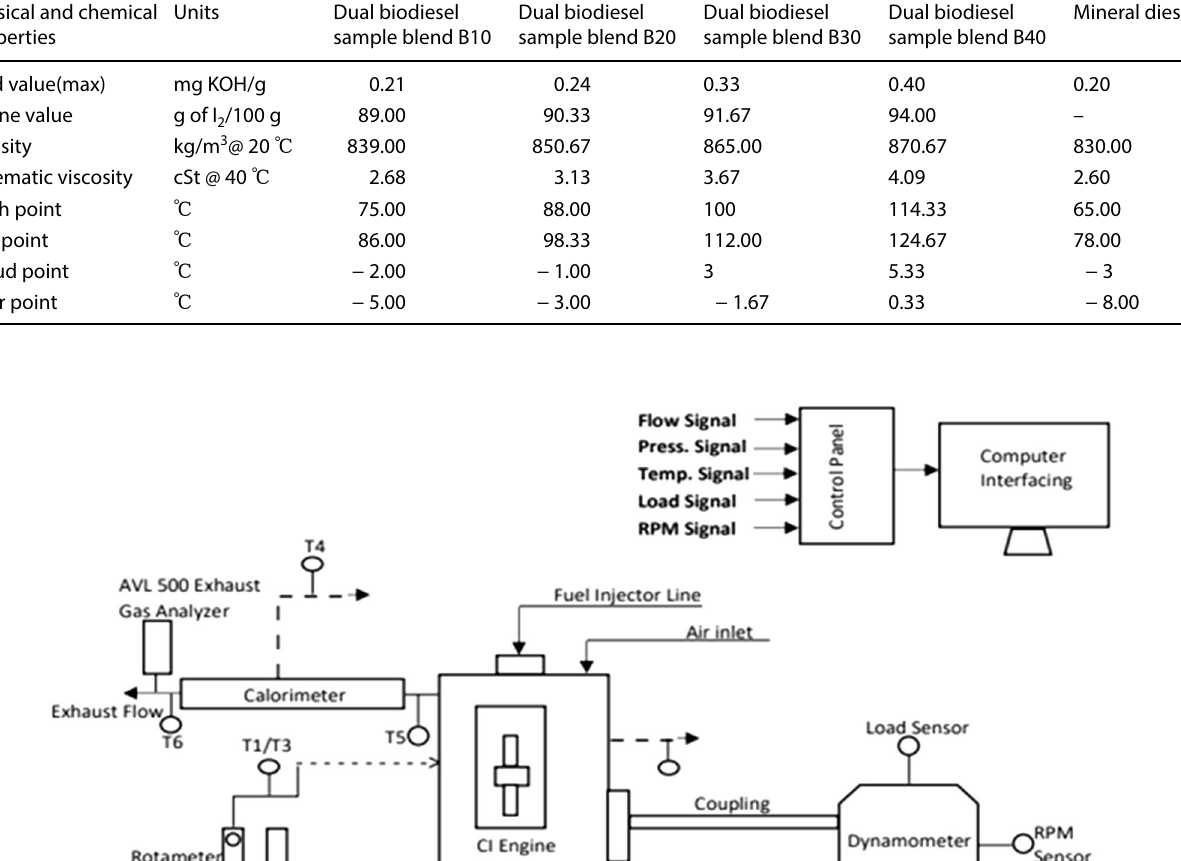
Table 3 The comparison of properties (physical and chemical) of various dual biodiesel blend samples with the mineral diesel [47] Physical and chemical Units properties